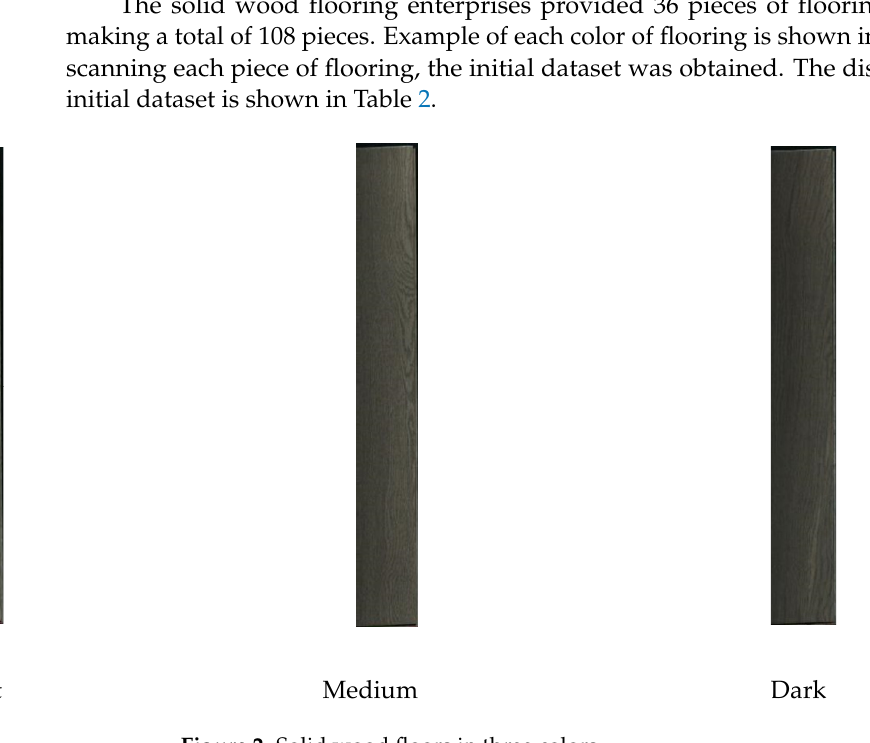
Figure 2. Solid wood floors in three colors. Table 2. Distribution of the initial dataset. Color